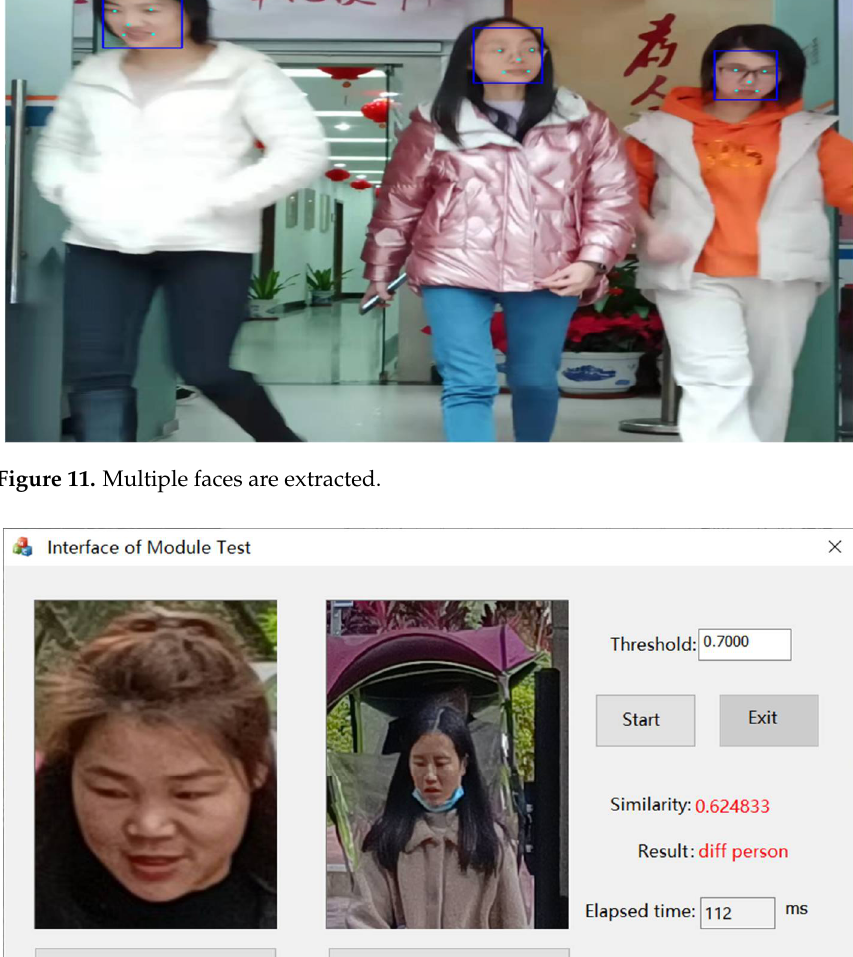
Figure 10. The same person is captured at the entrance and the exit.